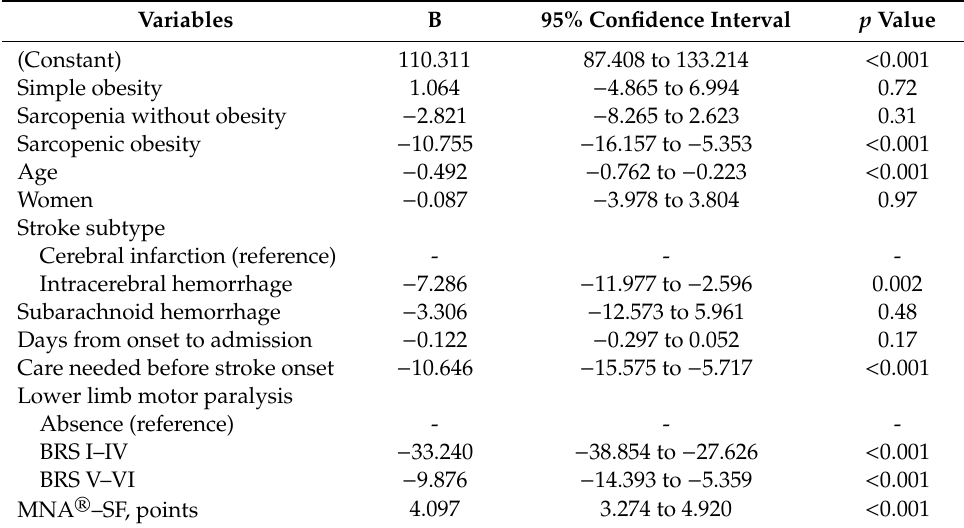
Table 2. Multivariate linear regression analysis for the FIM–total score *.